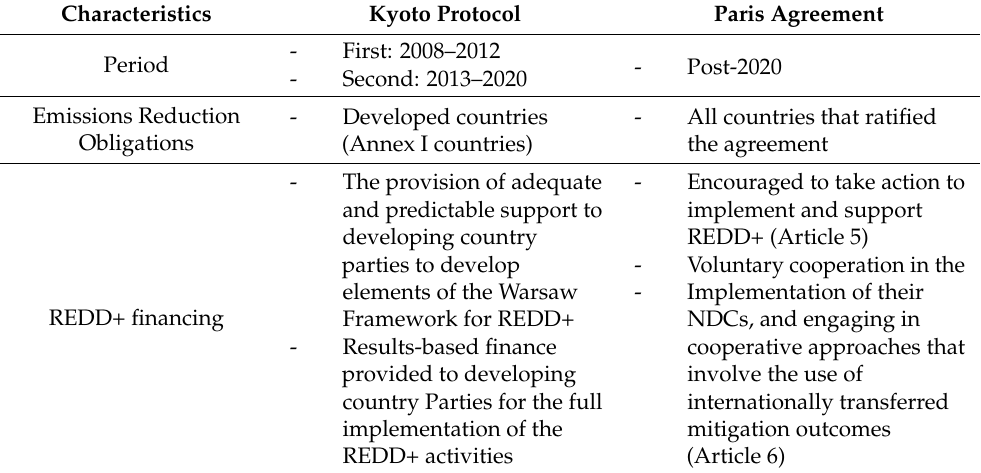
Table 2. Climate regimes and REDD+ financing